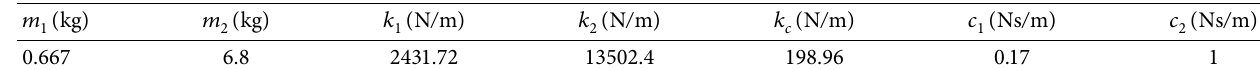
Table 1: Physical parameters of the coupled